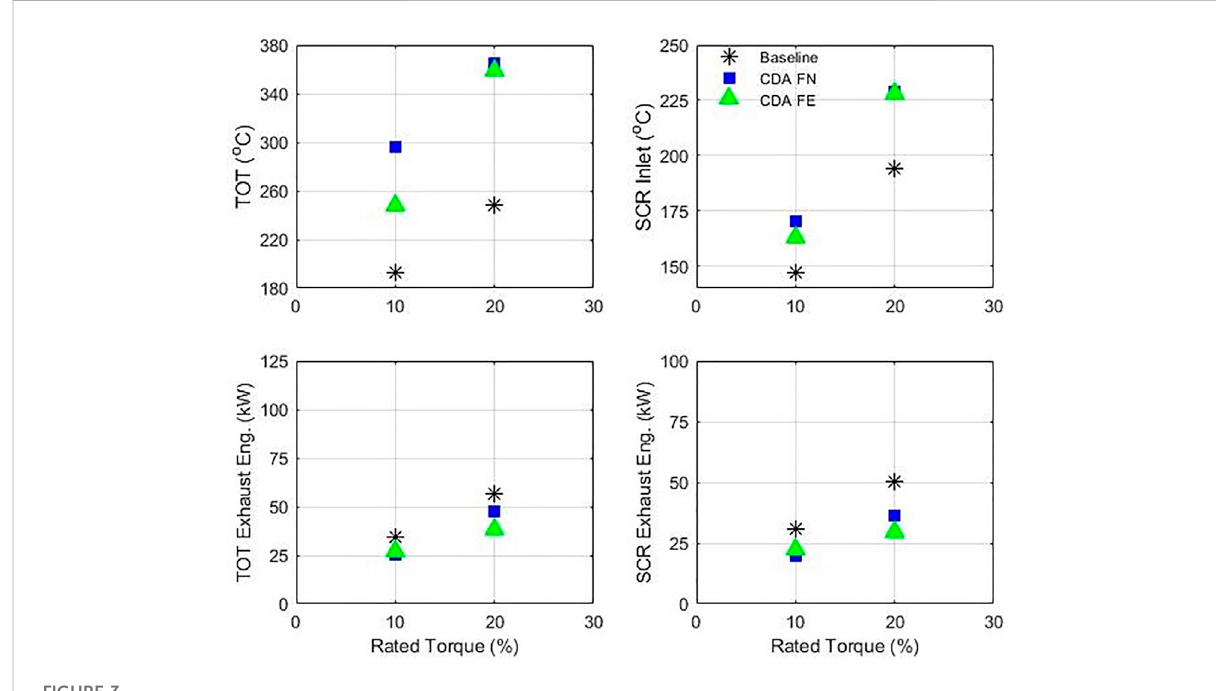
FIGURE 3 800 rpm steady state exhaust parameters.